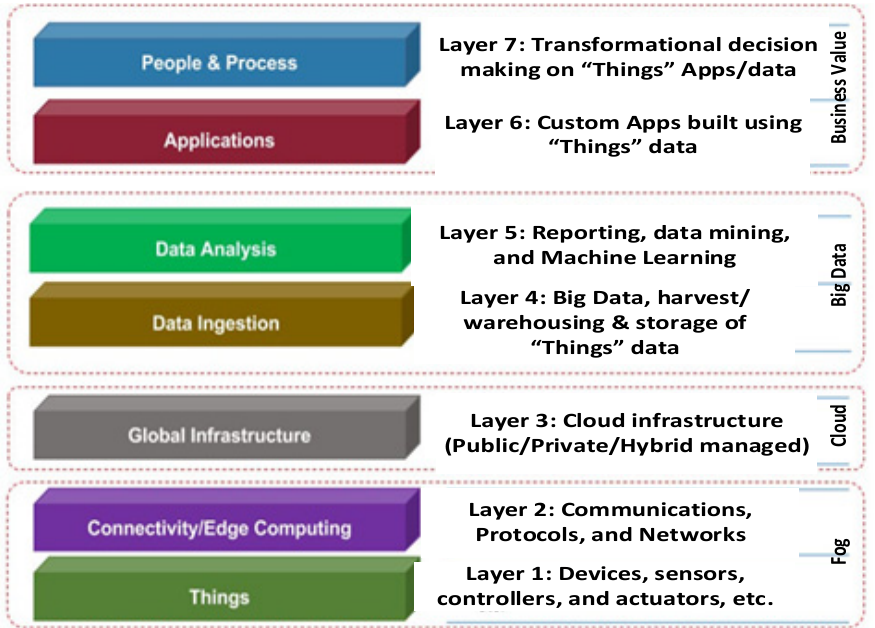
Figure 3. Seven-Layer IoT Architecture (adapted from [37]).